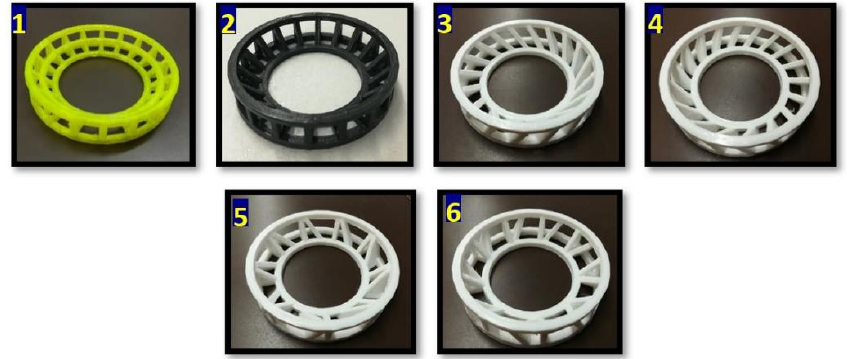
Figure 1. The designed PLA-based 3DP turbulence promoter configurations.